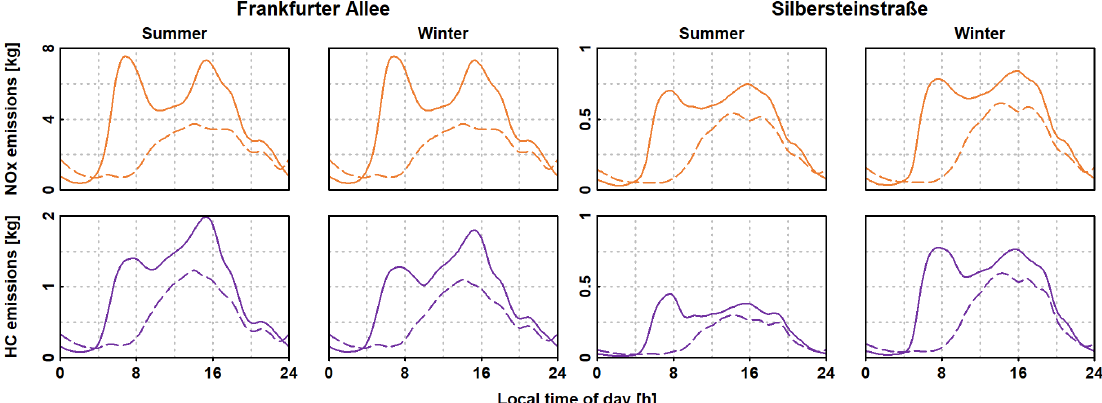
Figure 4. Diurnal emission profiles for NO x (top row) and HC (bottom row) from Yeti using mean summer and winter temperature profiles (Fig. 3 and Table 4) on Frankfurter Allee and Silbersteinstraße in Berlin. Solid lines indicate a traffic activity profile for a typical weekday, and dashed lines indicate a typical holiday traffic activity